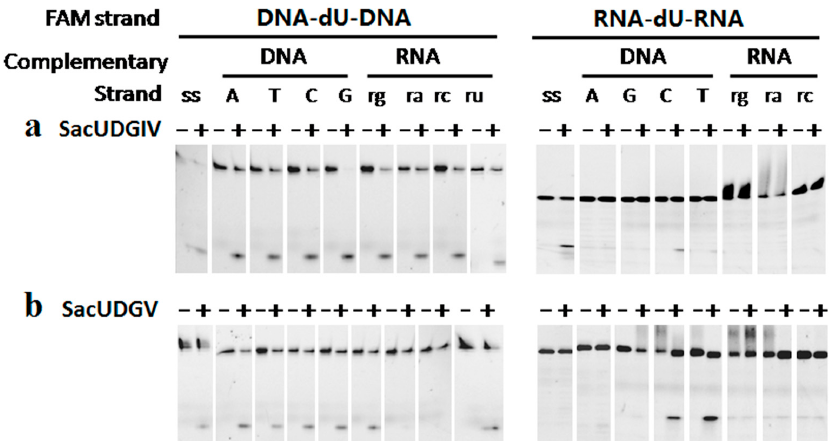
Figure 5. Effect of ribose and deoxyribose backbone on the removal of dU by SacUDGs. SacUDGIV ( a ) and SacUDGV ( b ) were incubated with 0.1 μ M single ‐ stranded (DNA ‐ dU ‐ DNA, RNA ‐ dU ‐ RNA)